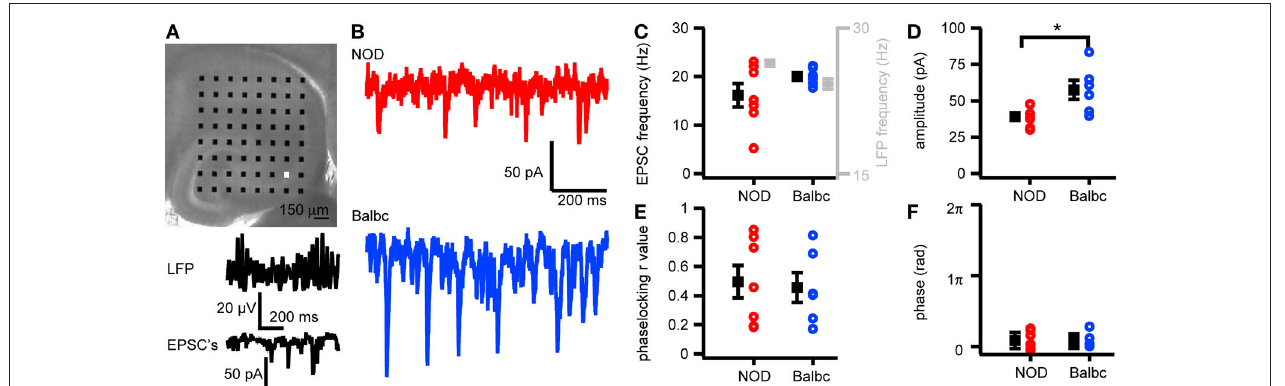
FiGuRe 4 | ePSCs in CA3 pyramidal cells in NOD and Balbc mice differ in amplitude. (A) Hippocampal slice placed on a 64 electrode grid and example traces of local field potential and corresponding EPSCs in a CA3 pyramidal cell from a NOD mouse recorded at the in the white colored electrode in the picture. (B) Example